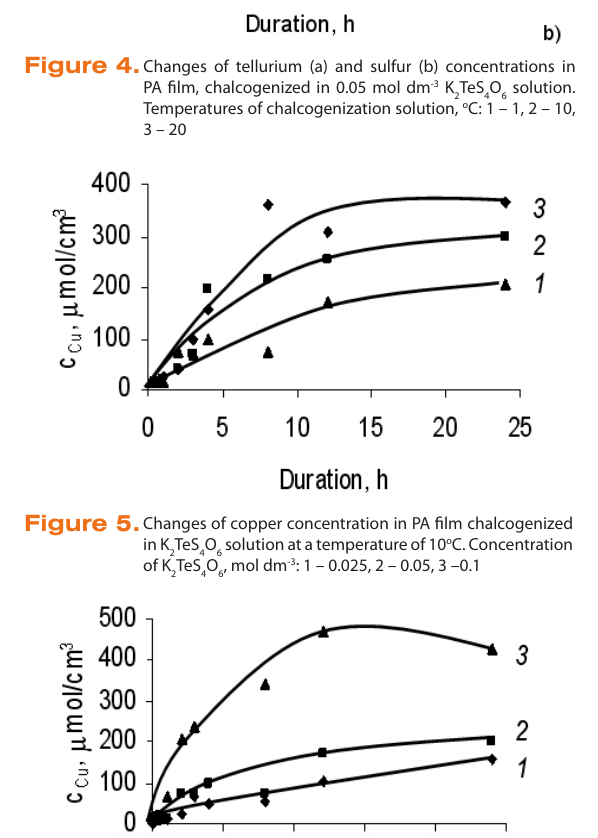
chalcogenized in 0.05 mol dm -3 K Temperature of K 3 –